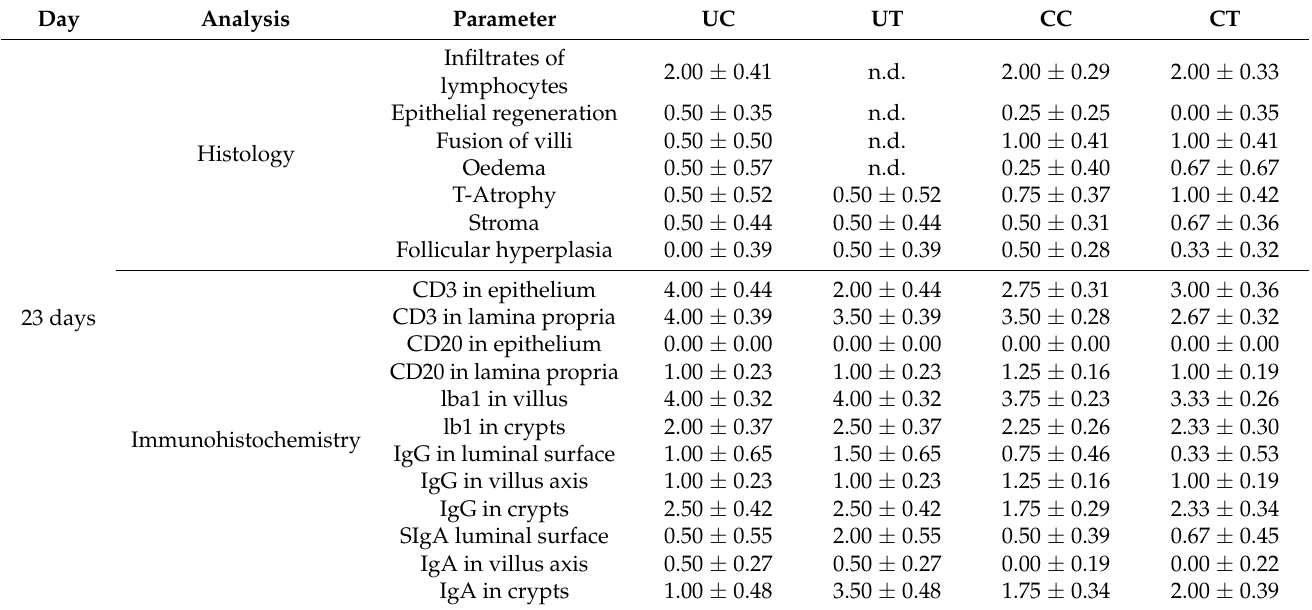
Table 2. Mean values of the histological parameters of the ileum sections among the experimental groups recorded at 23 and 29